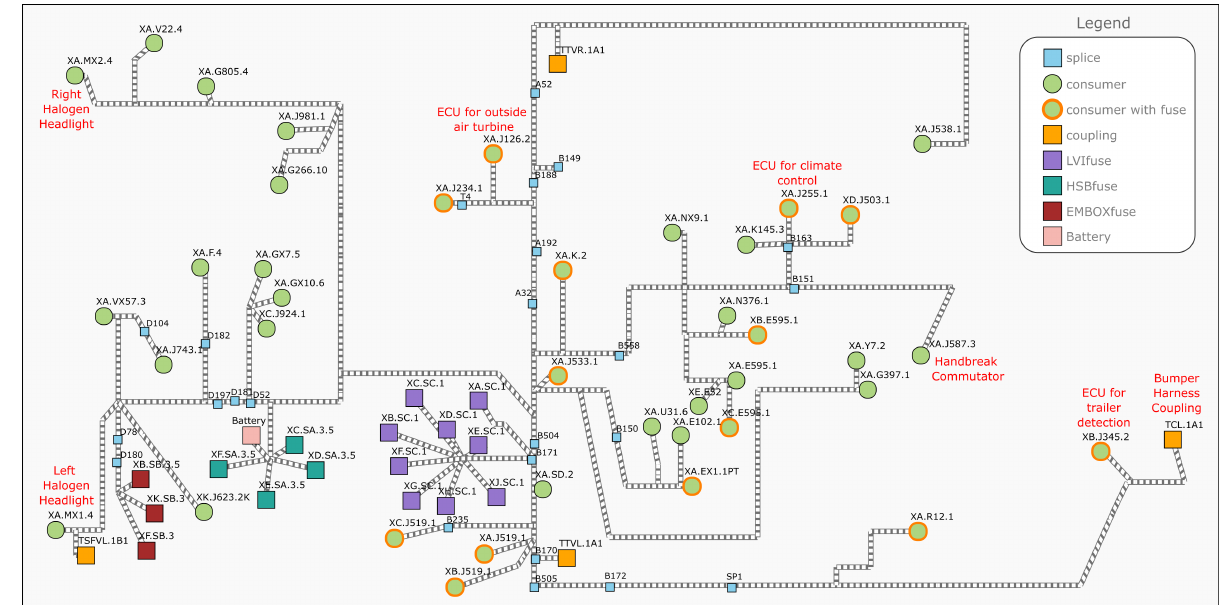
Figure 5. General View for the main harness of the SEAT Ibiza car model.